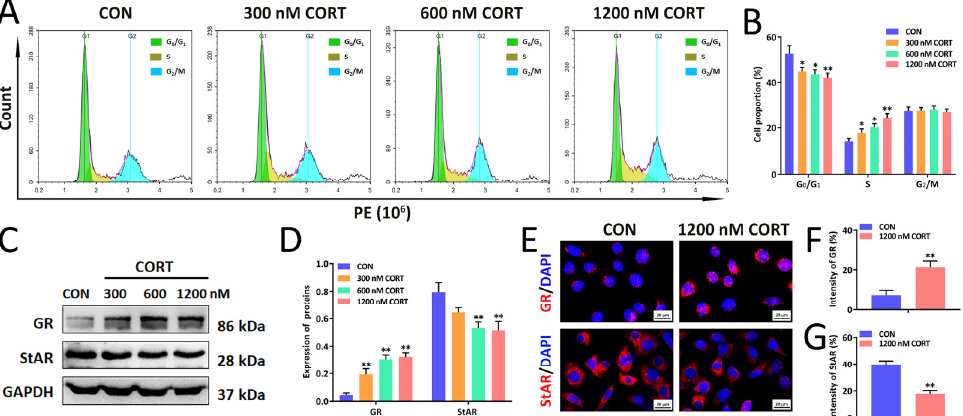
Figure 3. Corticosterone treatment suppresses GC-1 cell proliferation and decreases StAR expression. ( A , B ) Flow chart of cell cycle distribution ( A ) and cell cycle percentage statistics ( B ). ( C , D ) Representative immunoblot images of GR and StAR protein expression in GC-1 cells ( C ) and densitometric analysis ( D ). ( E – G ) Representative images of immunofluorescence assay of GR and StAR in GC-1 cells ( E ) and densitometric analysis ( F , G ). Original magnification: 400 × , scale bar: 20 µ m. Means ± S.E.M, n = 5, * p < 0.05, ** p < 0.01 vs. CON (control).